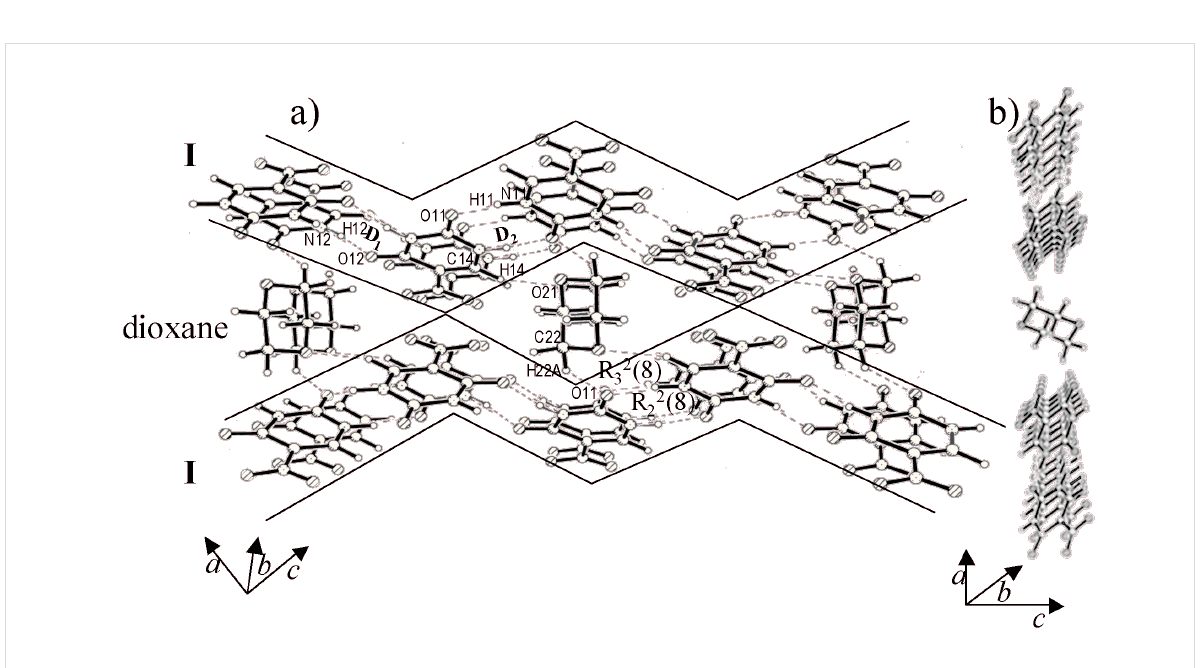
Figure 1: Dioxane molecules held between the zig-zag rows of I , viewed (a) perpendicular and (b) parallel to the molecular layer. Cyclic arrange- ments of bonds are marked using Etter's notation